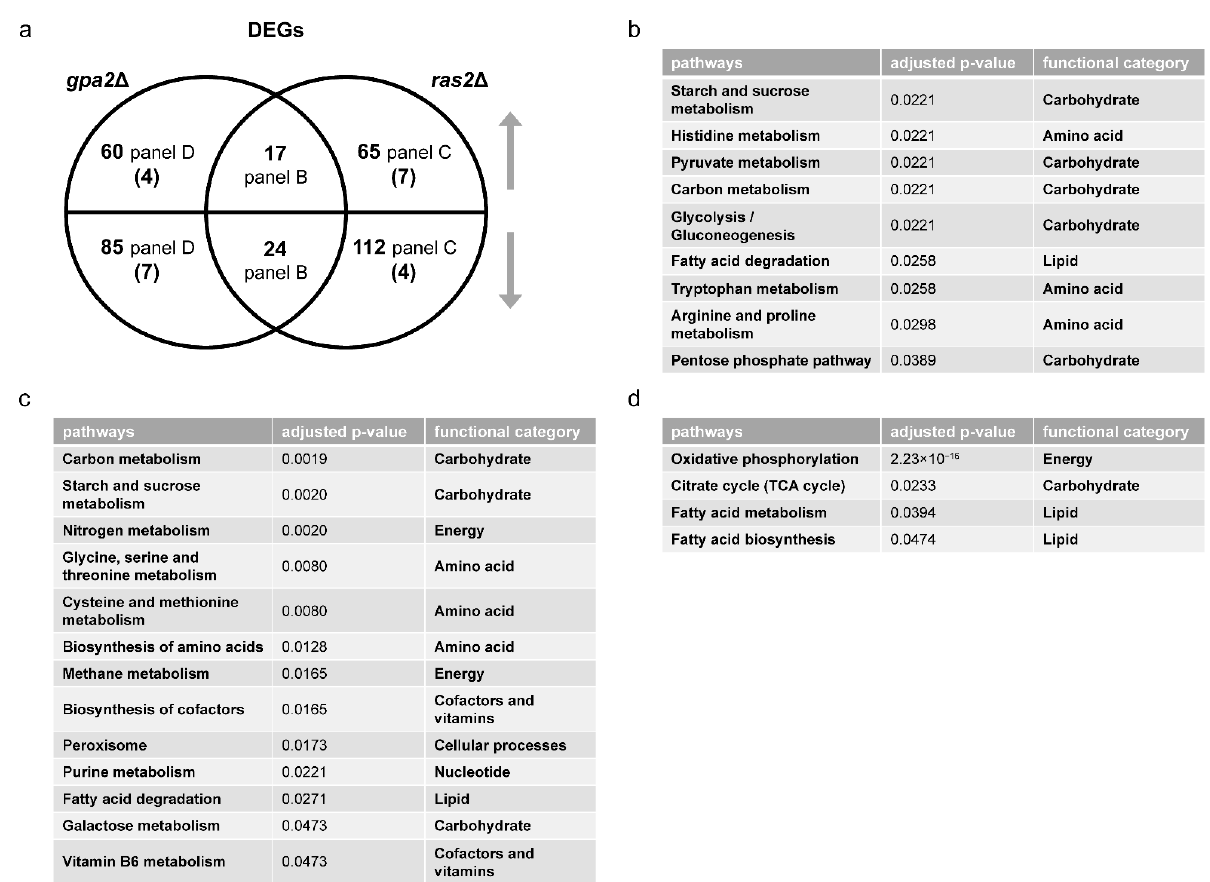
Figure 5. Comparing differentially expressed genes (DEGs) of gpa2 Δ and ras2 Δ . ( a ) Venn diagram of subsets of DEGs, for gpa2 Δ vs. wildtype and ras2 Δ vs. wildtype, after glucose addition to 2%. Upper semicircle shows up-regulated DEGs and lower semicircle shows down-regulated DEGs. Numbers in the overlapping region are shared DEGs regulated in the same direction. Numbers in parenthesis are shared DEGs regulated in the opposite direction, and are placed in the area corresponding to the direction of regulation. DEGs used for ORA analysis that are ( b ) shared and change in the same direction; ( c ) unique to ras2 Δ ; ( d ) unique to gpa2 Δ . Listed are all pathways and their functional categories with adjusted p -value < 0.05.